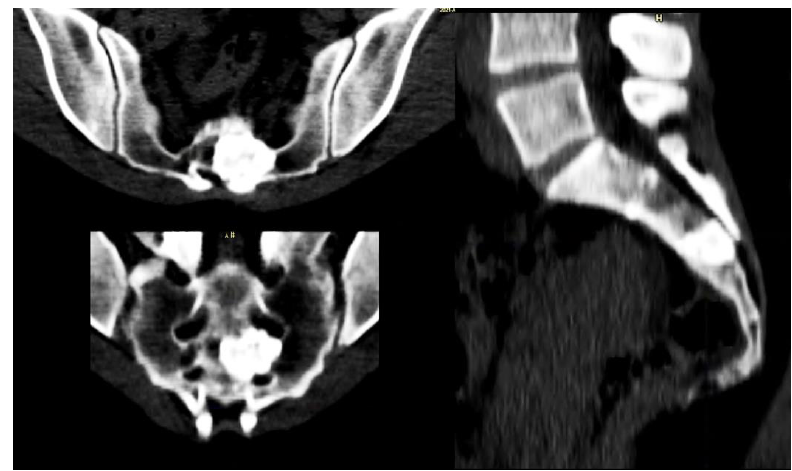
Figure 3. Forty-seven-year-old female patient affected by OBL of S3.